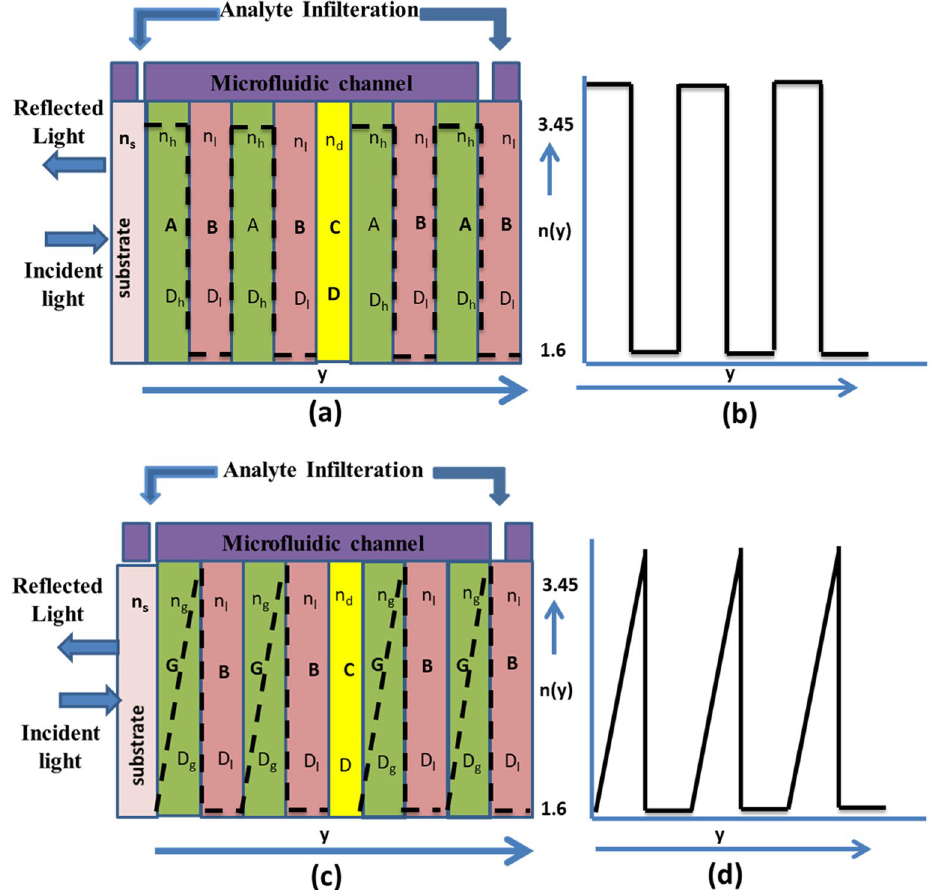
Figure 1. Schematic representation of proposed structure. ( a ) Step index photonic crystal resonator, ( b ) corresponding refractive index variation, ( c ) Exponentially Graded index multilayer resonator structure, and ( d ) corresponding refractive index